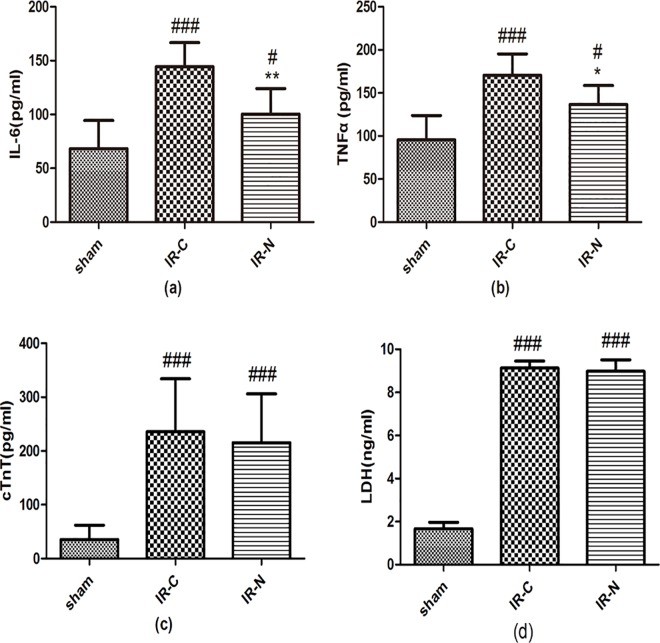
The new method has less inflammation and equal cardiac damage.The plasma concentration of IL-6 (a) (n = 8), and TNF-α (b) (n = 8), cTnT (c) (n = 8) and LDH (d) (n = 4) were measured at 24 h after surgery in the different groups. The plasma levels of TNF-α and IL-6 in I/R-N group was significantly lower than I/R-C group. However, the plasma levels of cTnT and LDH were no difference between I/R-N group and I/R-C group. #p<0.05, ###p<0.001 vs. sham;*p<0.05, * *p<0.01 vs. I/R-C.